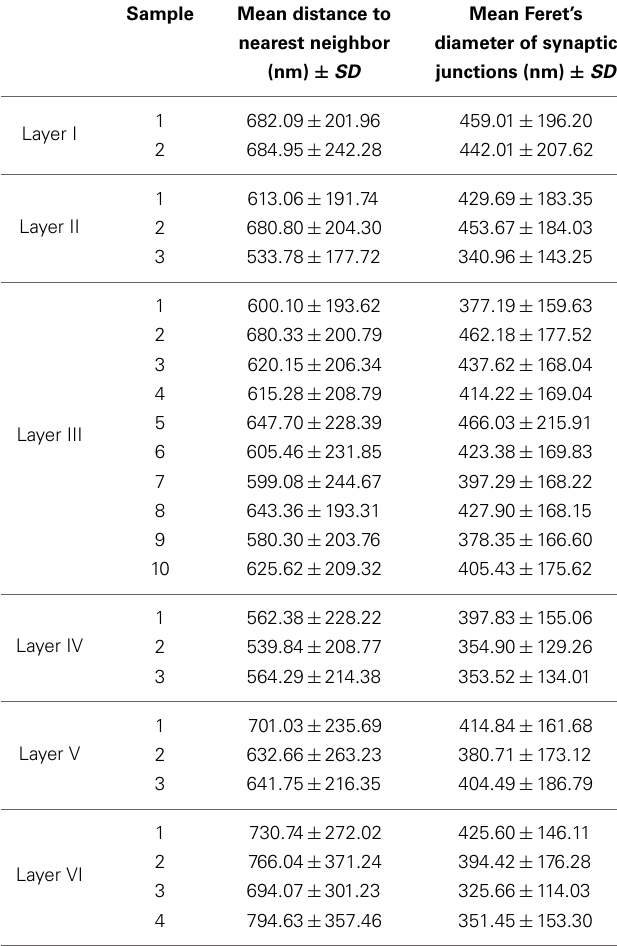
Table 2 | Mean distances from a synapse to its nearest neighbor and mean Feret’s